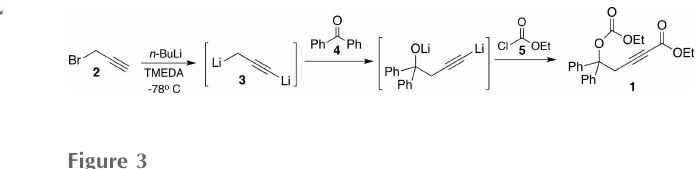
Figure 3 A synthetic scheme for the preparation of the title compound.